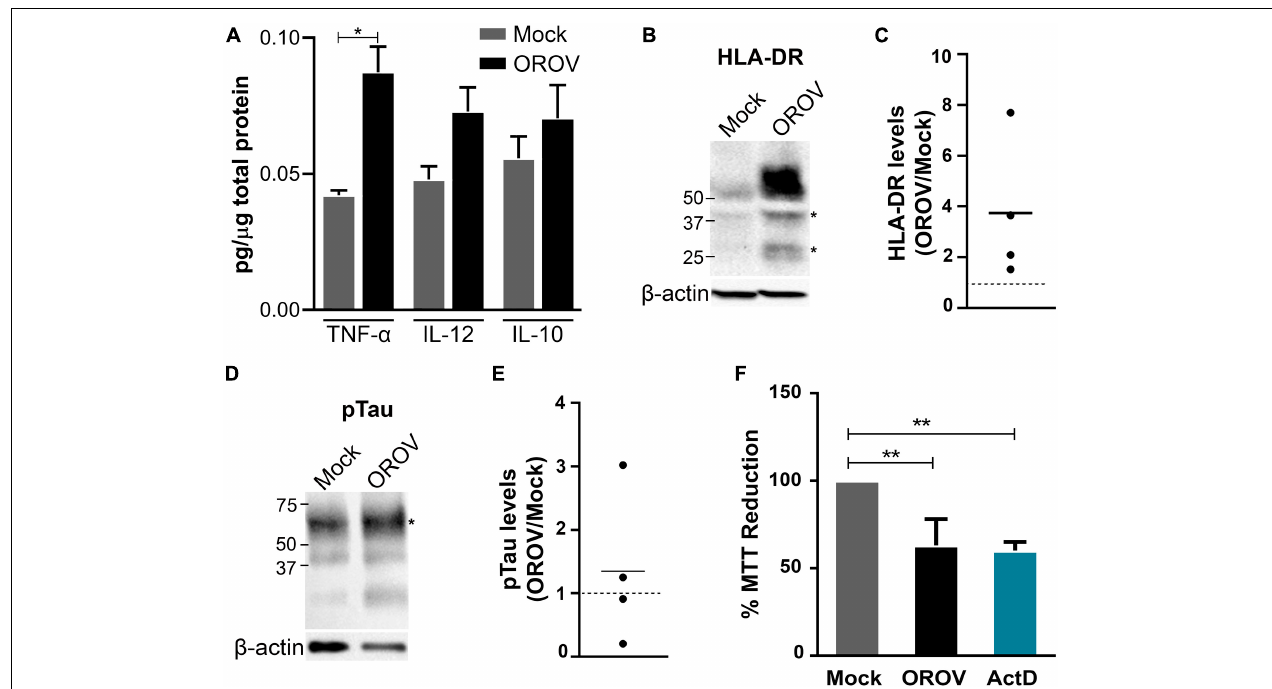
FIGURE 5 | Oropouche virus infection induces an inflammatory and toxic response in adult human brain slices. (A) Cytokine levels in supernatants of brain slice cultures ( n = 3 donors; * P < 0.05; Student t -test). (B,D) Representative immunoblots probing HLA-DR or phosphorylated Tau (pTau), respectively. Bands used for quantification are indicated with asterisks (*). β -actin was used for normalization. (C,E) HLA-DR/ β -actin and pTau/ β -actin ratios in four independent infected slices. Mock levels are indicated by dotted lines ( n = 4 donors). (F) Cell viability in slices determined by the MTT assay 48 hpi. Actinomycin D (ActD) was used as positive control for cell death ( n = 3 donors; ** P < 0.001; One Way